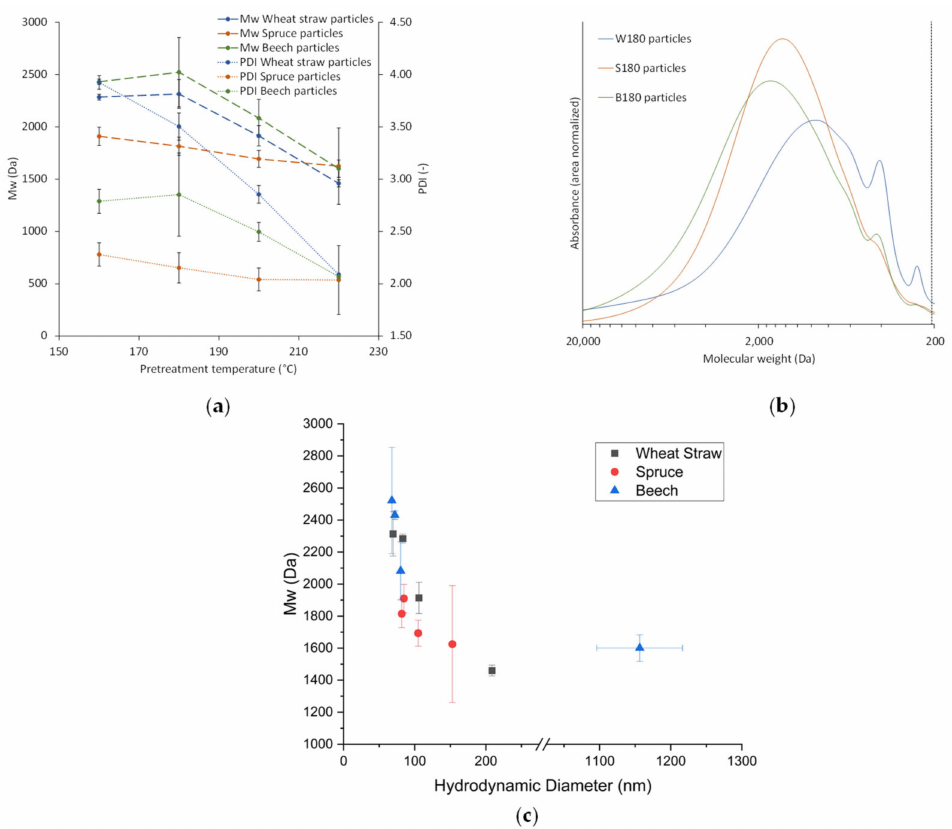
Figure 7. M w and PDI of lignin particles ( a ), molecular weight distribution of particles from different raw materials at 180 ◦ C pretreatment temperature ( b ), M w of particles over diameter of particles ( c